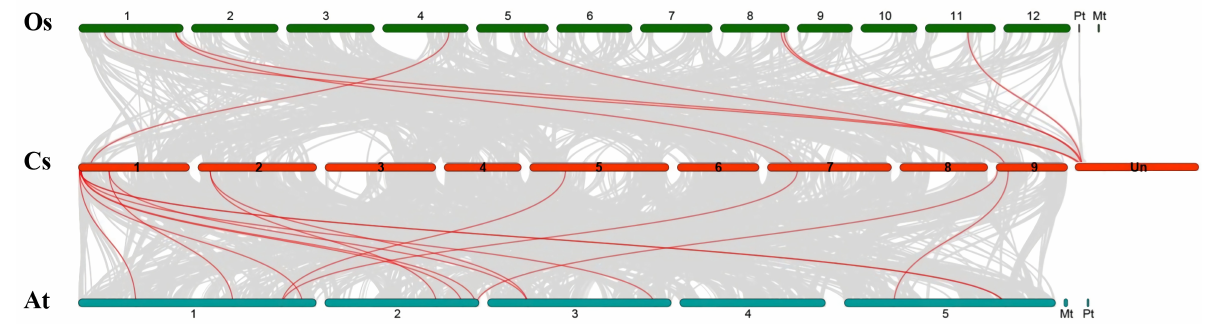
Figure 4. The homologous gene pairs between sweet orange and Arabidopsis and sweet orange and rice. Gray lines in the background indicate the collinear blocks within sweet orange and Arabidopsis and sweet orange and rice genomes. Red lines indicate homologous gene